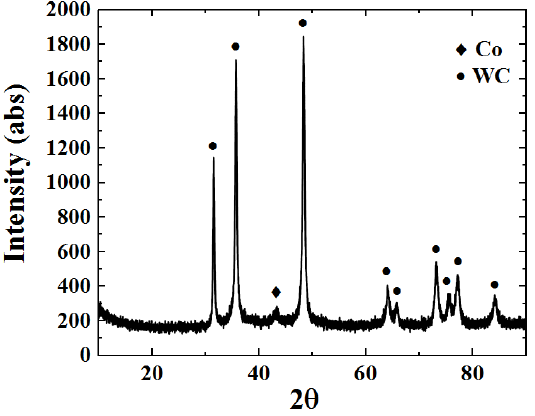
Figure 13. WC-12Co coating XRD phase map.